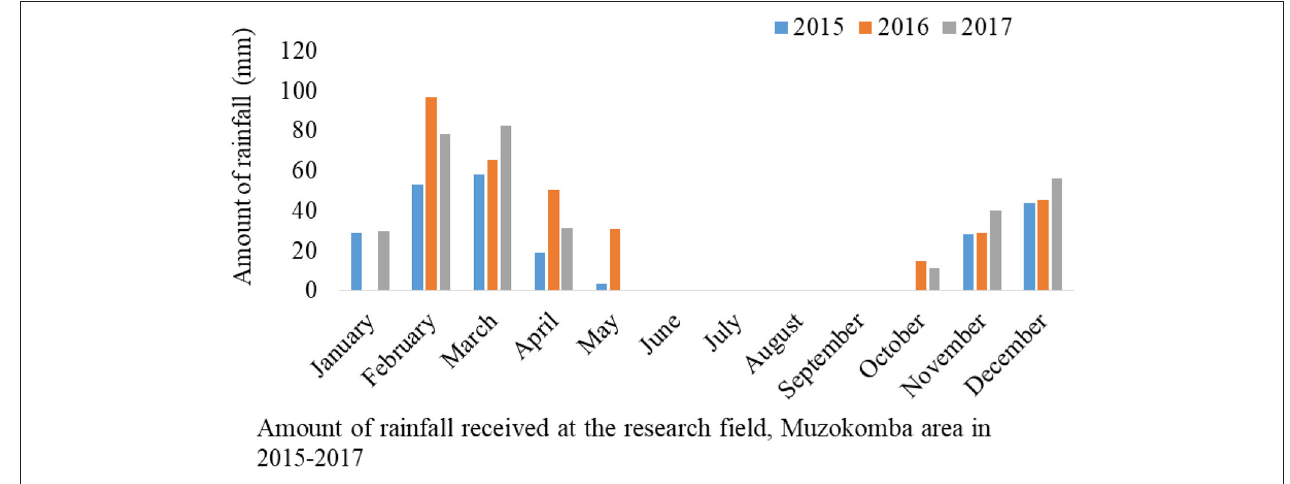
FIGURE 1 | The average rainfall (mm) recorded at the research field during the period